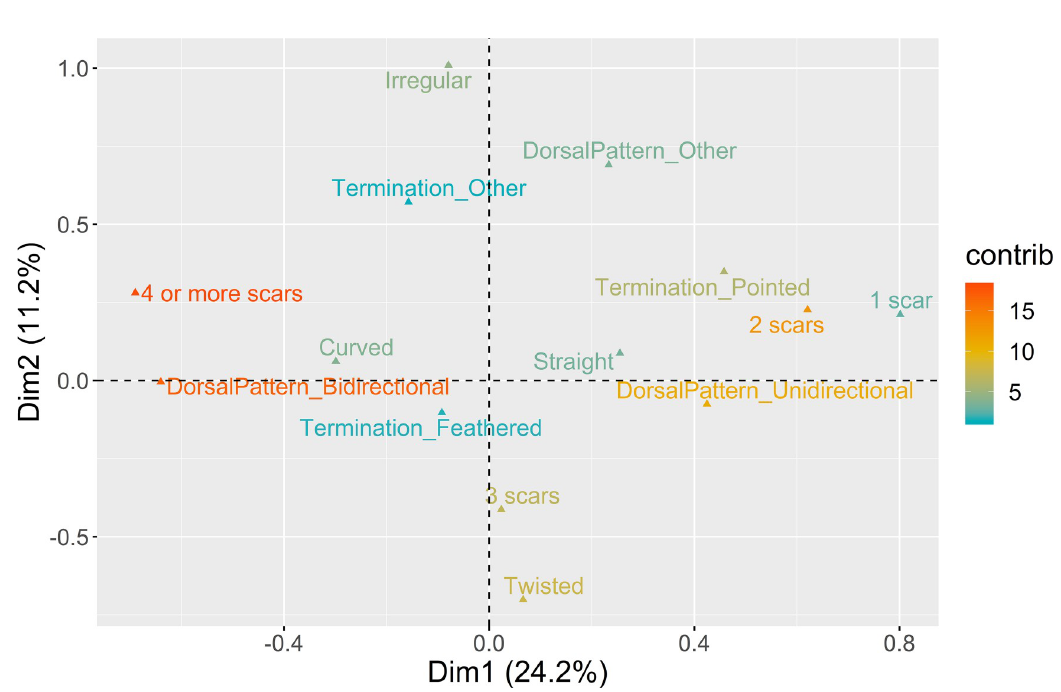
Fig 11. Multiple correspondence analysis plot (first two dimensions) for elongated blanks techno-morphology. The color ramp represents the contribution (in %) of the variable categories to the definition of the dimensions.